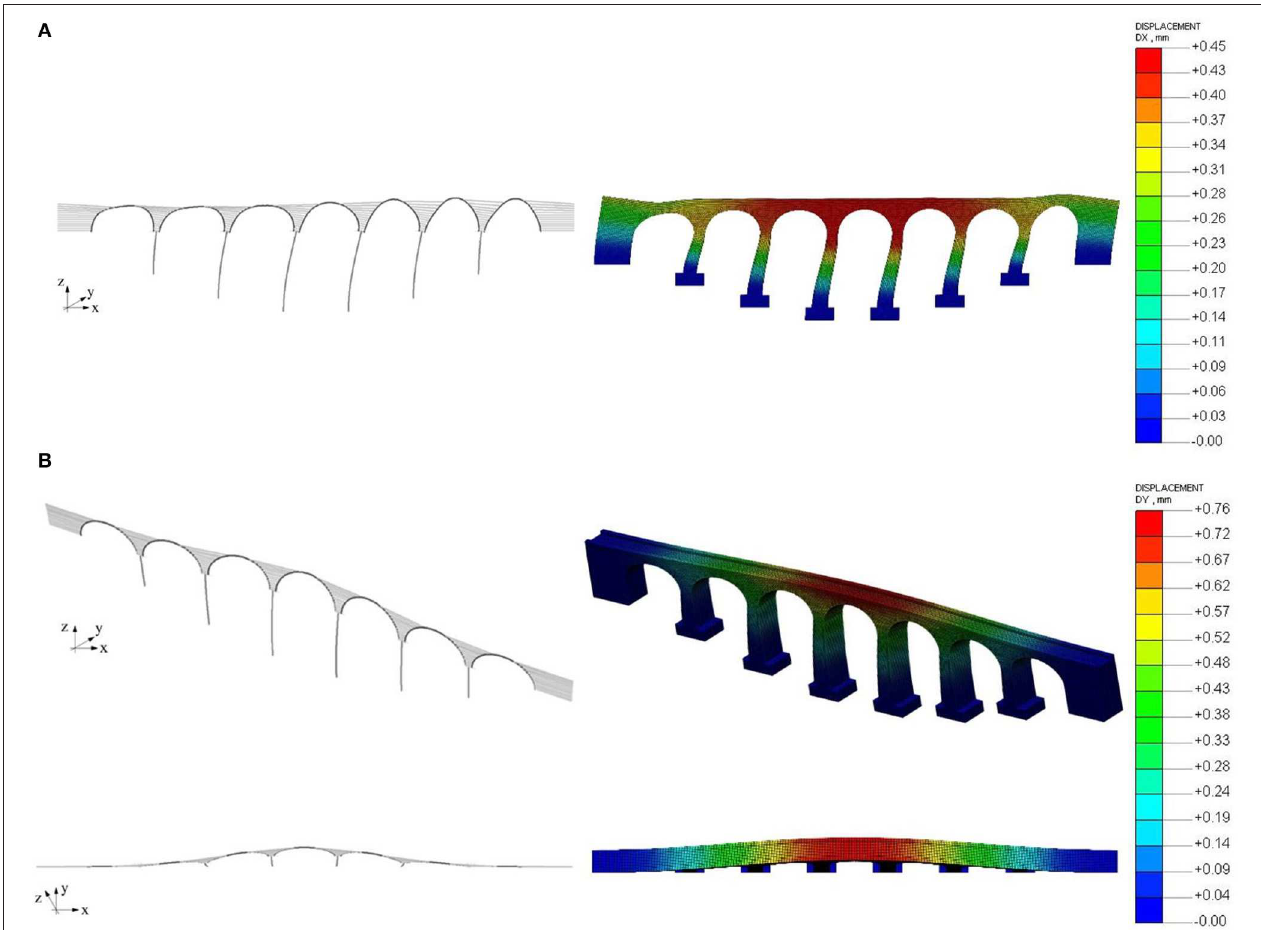
FIGURE 7 | Results from FEM analyses. (A) First significant vibration mode in the longitudinal direction (X) of the Fiber-beam model. (B) First significant vibration mode in the longitudinal direction (X) of 3D model.